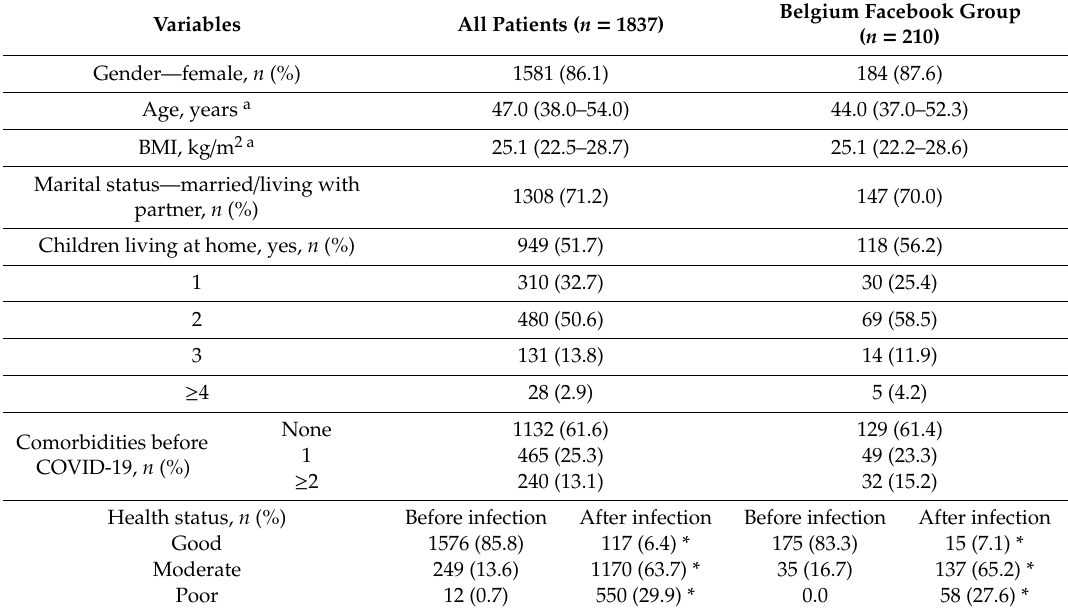
Table 1. Patient characteristics.